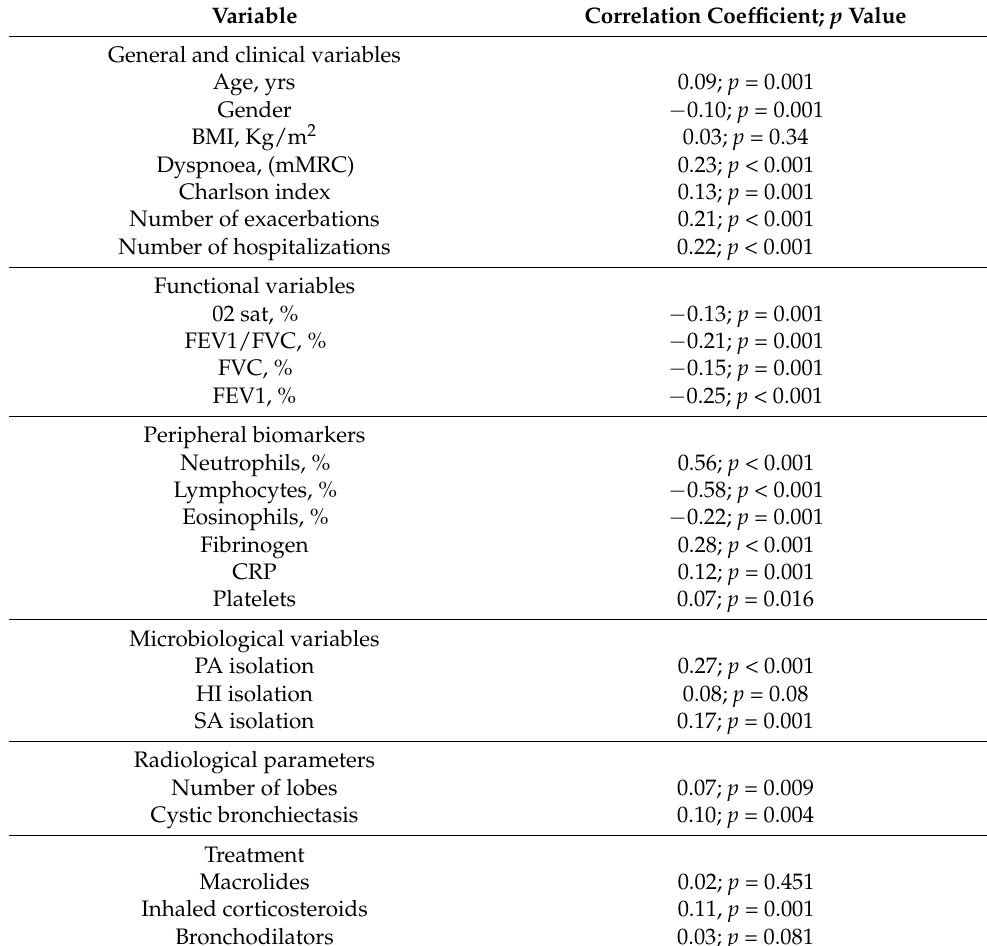
Table 2. Correlation between NLR value and general, clinical, functional, biological, microbiological, radiological and therapeutic